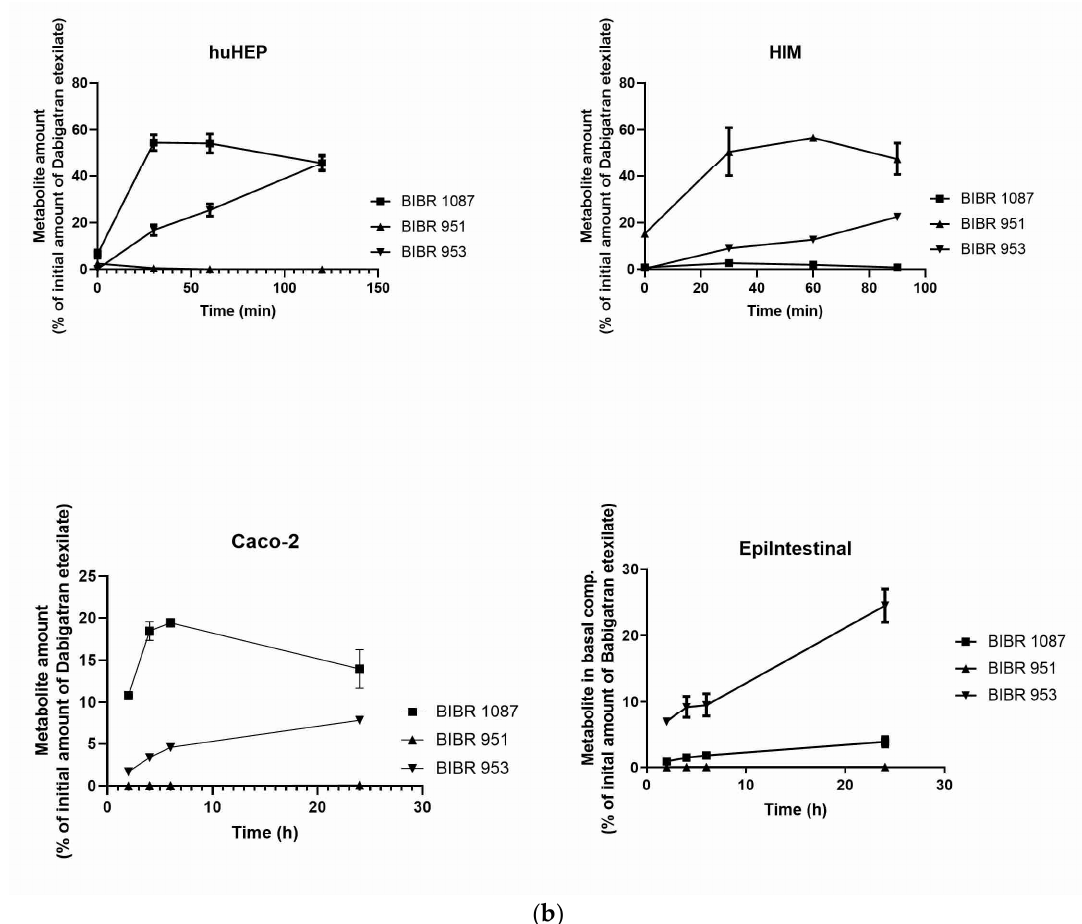
Figure 3. Metabolic pathways and metabolite pattern of dabigatran etexilate. ( a ) Metabolic pathways of dabigatran involving CES1 and CES2. ( b ) Detection of metabolites of dabigatran etexilate in human hepatocytes (huHEP), human intestinal mucosa (HIM), Caco-2 cells, and EpiIntestinal microtissues. Dabigatran was incubated with hepatocytes and intestinal mucosa in suspension, or given to the apical compartment of Caco-2 cells and EpiIntestinal microtissues and incubated at 37 °C. At the indicated timepoints, samples were taken from the suspension of huHEP and HIM or from the basal compartments of Caco-2 cells and EpiIntestinal microtissues. The metabolites were quantified using LC-MS/MS. Data shown as the mean and SD of triplicates.